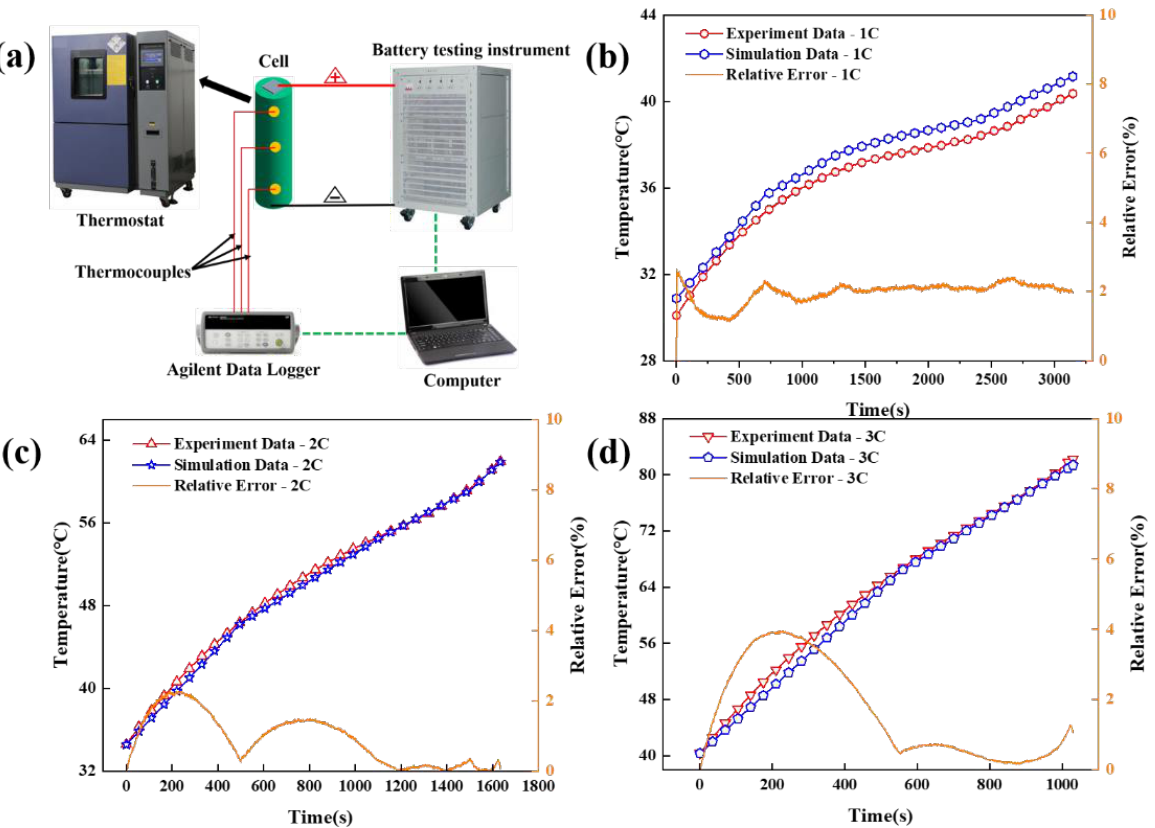
Figure 4. ( a ) The experiment setup; comparison of the experimental data and simulating results during different discharge processes: ( b ) 1C, ( c ) 2C, ( d ) 3C. Table 6. Heat generation rate of the 18650-type battery at different discharge rates.